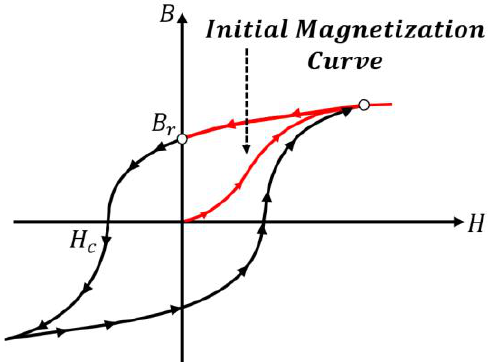
Figure 1. Hysteresis curve and magnetization principle of a PM.